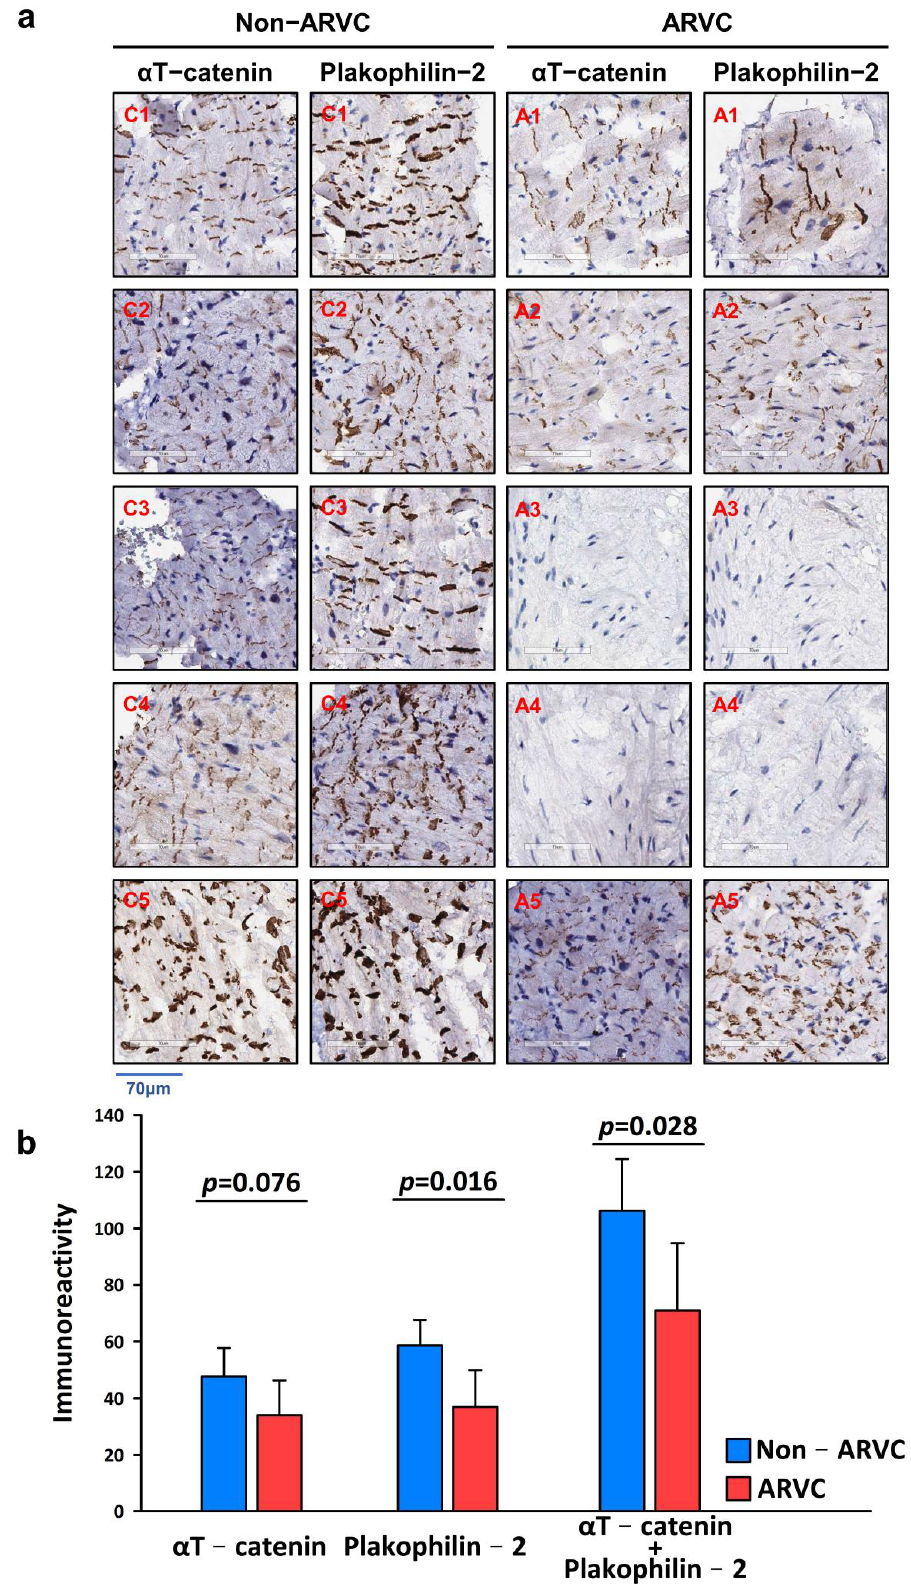
Figure 2. Representatives of myocardial immunohistochemistry images of specimens from clinical endomyocardial biopsies. ( a ) IHC staining of right ventricular tissues collected via endomyocardial biopsy was performed using α T-catenin and plakophilin-2 antibodies. ( b ) The immunoreactive intensity was assessed using